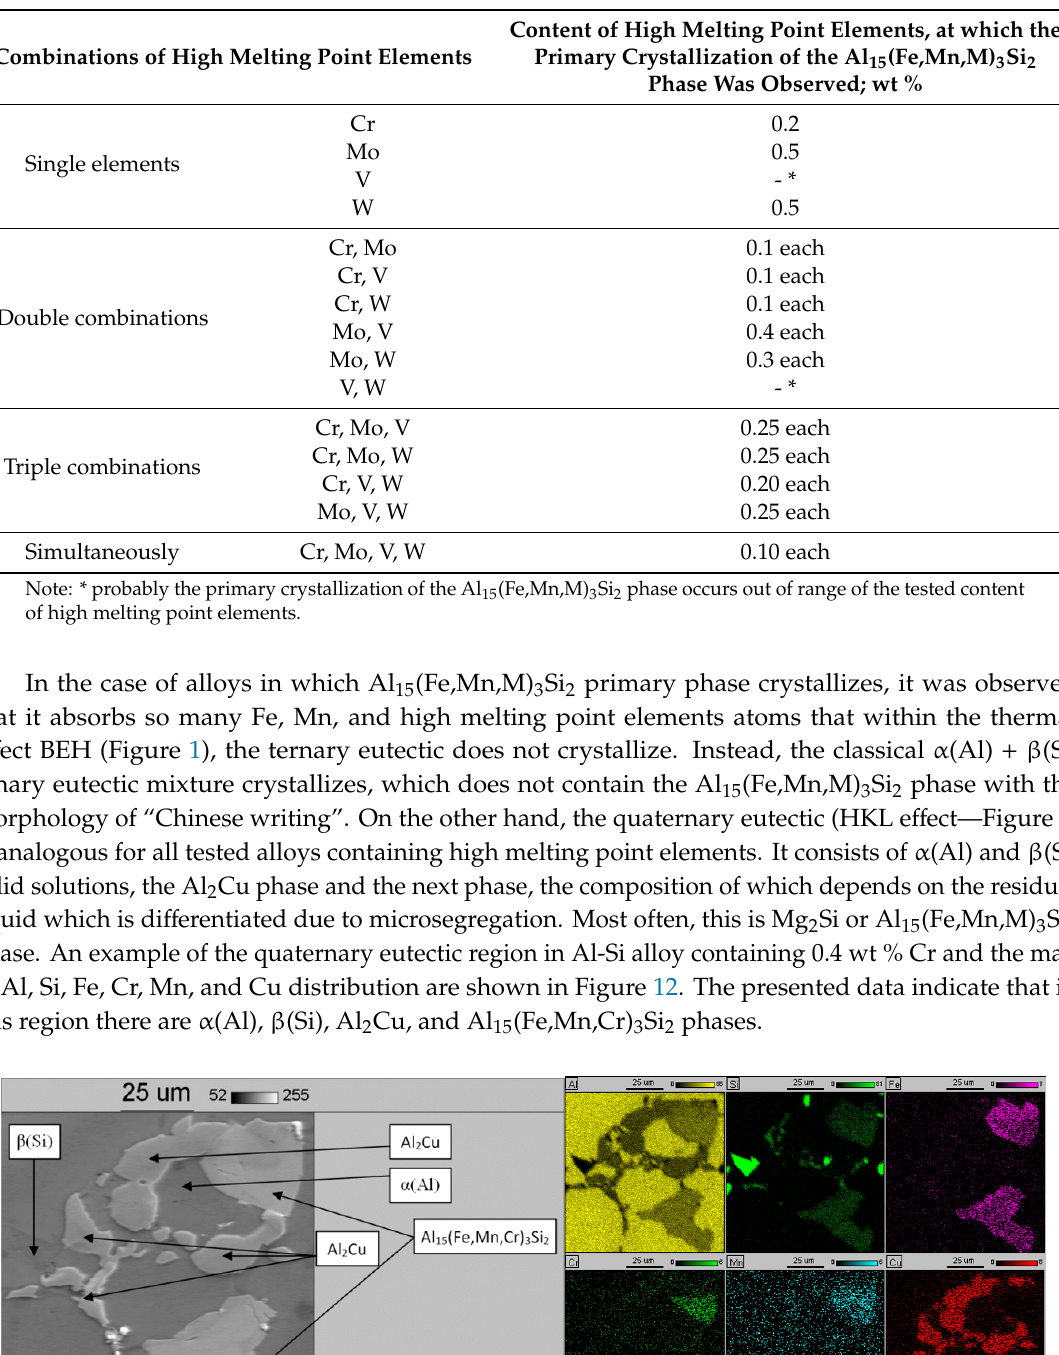
Table 3. Minimum content of high melting point elements, at which the primary intermetallic Al 15 (Fe,Mn,M) 3 Si 2 phases were observed.